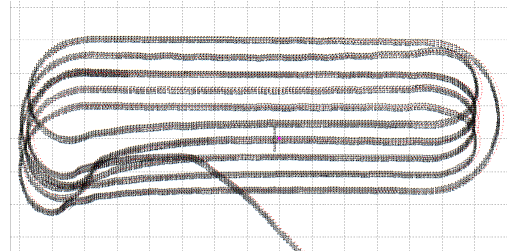
Figure 8. Flight path of the carrier UAS